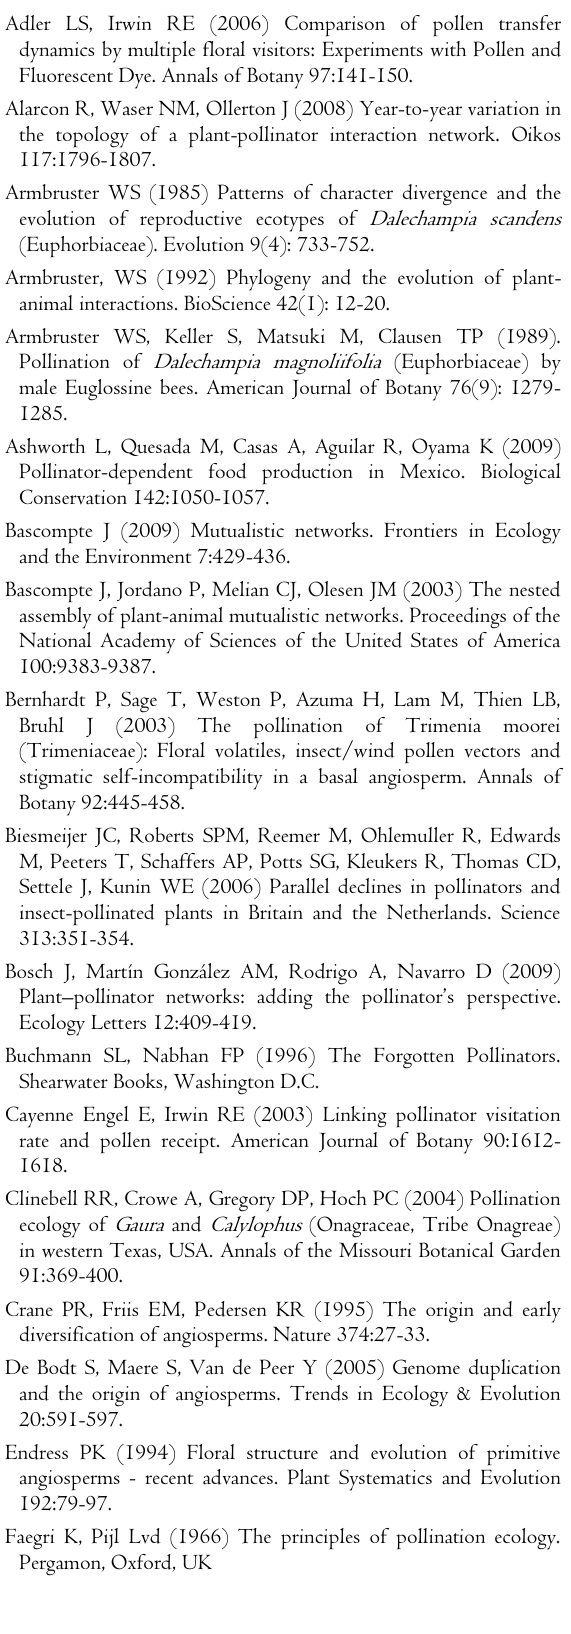
Table of field sites used in pollinator